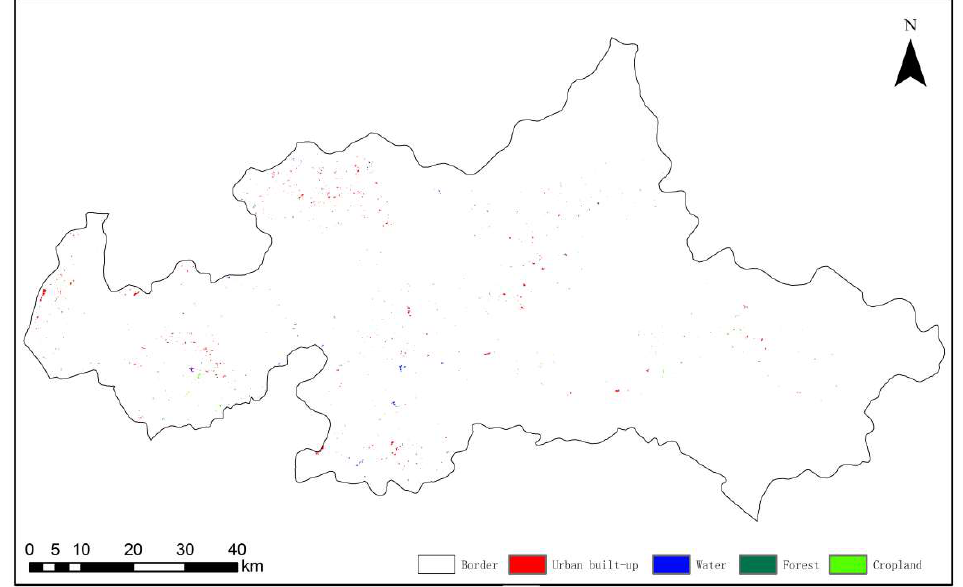
Figure 12. Classification results for changed types.